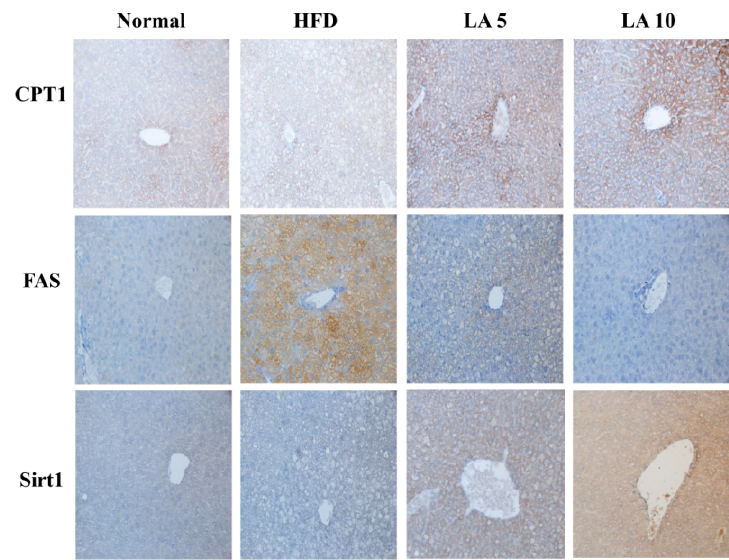
Figure 6. Licochalcone A (LA) modulated FAS, sirt-1, and CPT-1 expression in the liver. Expression levels of CPT-1, sirt1, and FAS were analyzed by immunohistochemistry and labeled as a brown color drop.